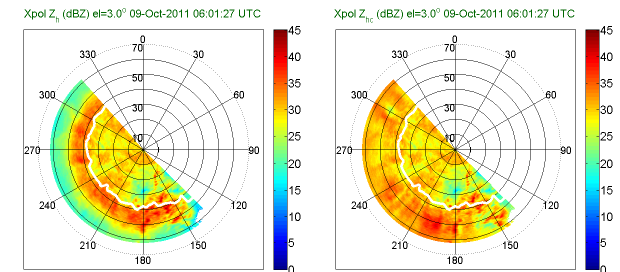
Figure 8. Example of VPR correction of XPol PPI scan at an antenna elevation of 3.0 o during Fig. 8. Example of VPR correction of XPol PPI scan at an antenna the rain event on 9/10/2011, showing the bright band due to the melting layer. elevation of 3.0 ◦ during the rain event on 9 October 2011, showing 2 the bright band due to the melting layer.